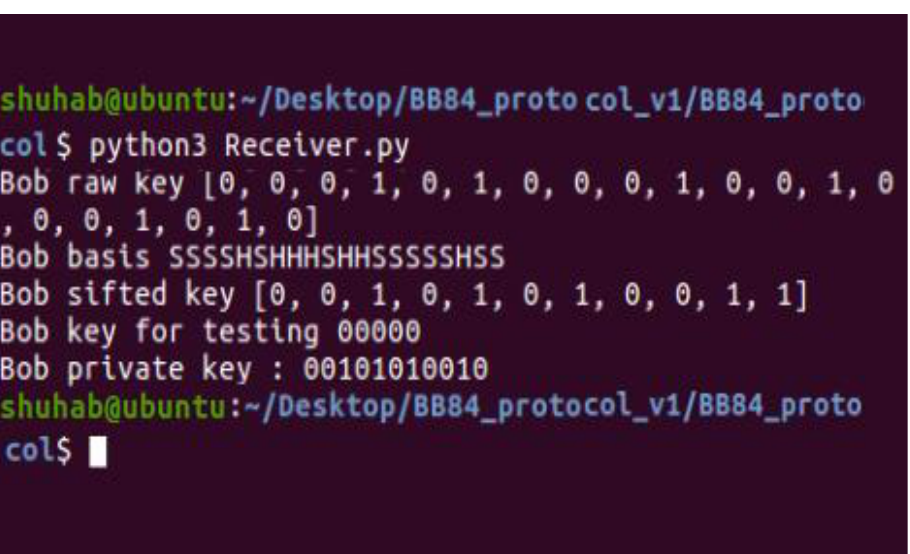
Figure 4. Execution of the Sender.py.